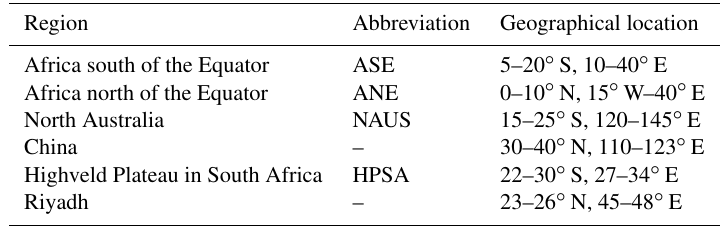
Table 3. Selected regions for NO 2 time series with their abbreviation and their location.